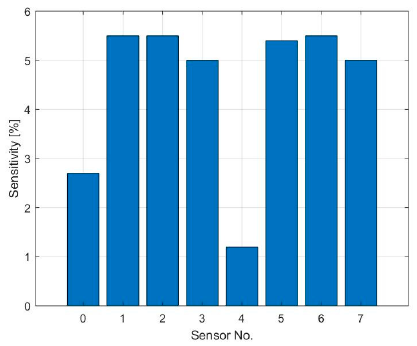
Figure 7. Summary of the sensitivity towards 100 ppb of NO 2 of the 8 sensors.